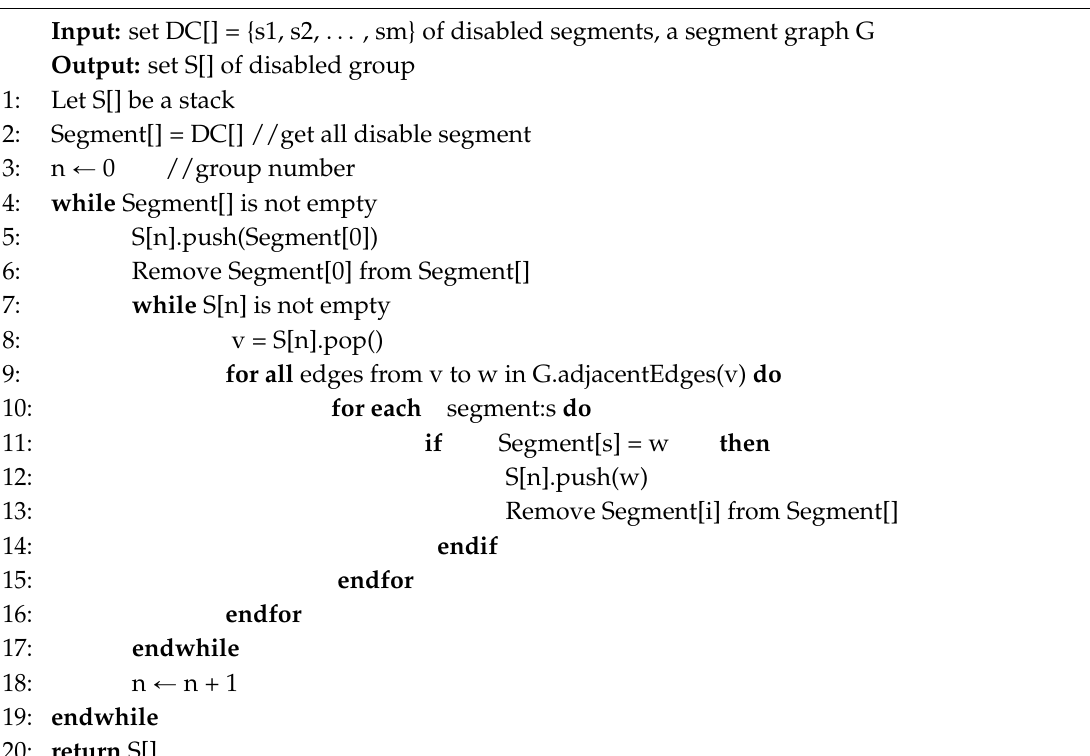
Algorithm 2. disabled_coverage_grouping (DC[],